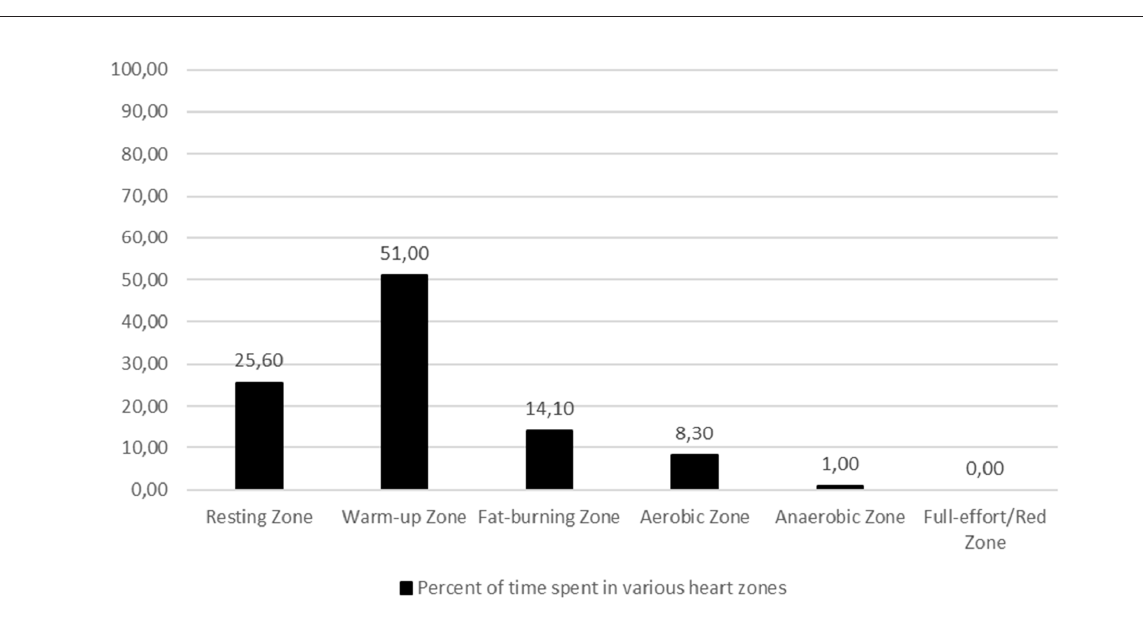
Figure 2. Average percent of time spent in different heart rate zones, based on age-adjusted maximal heart rates, during laughter yoga practice (n = 16) in Study 2. Note: Resting zone = under 50% of the maximal heart rate (MHR); warm-up zone = 50-60% MHR; fat-burning zone = 60-70% MHR; aerobic zone = 70%-80%; MHR; anaerobic zone = 80-90%; full effort/red zone = > 90% MHR.